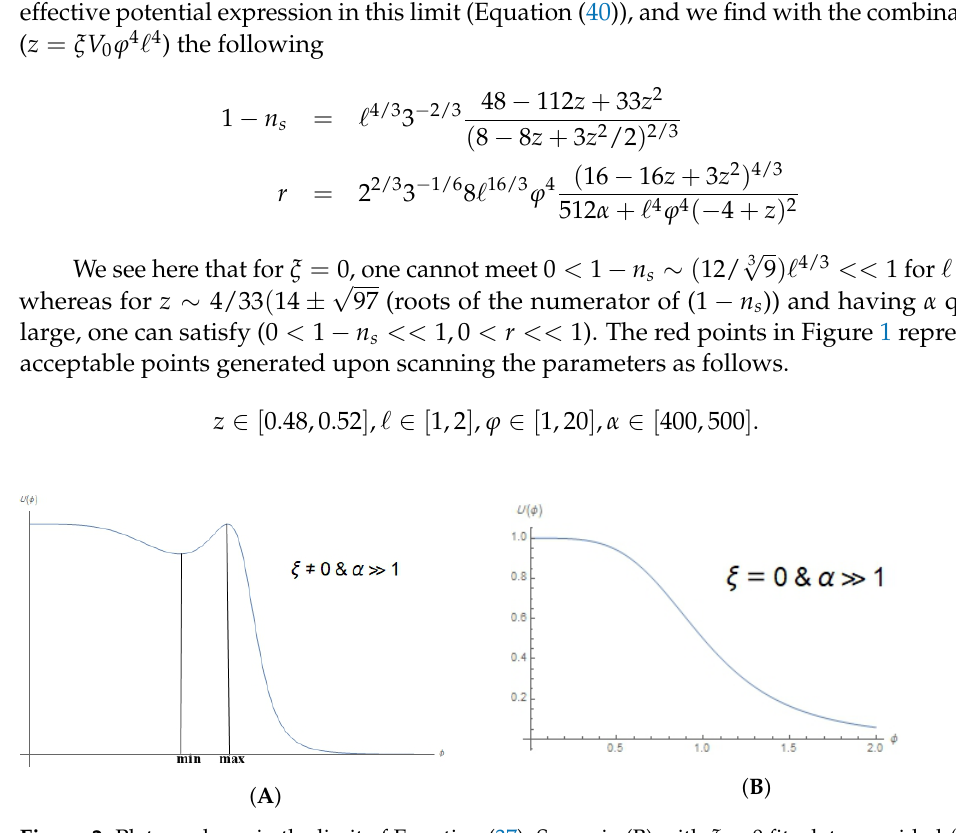
Figure 2. Plateau shape in the limit of Equation (37). Scenario (B) with ξ = 0 fits data provided (cid:96) < 1. − 1/4 ; ( B ). ξ = ) 1/4 (cid:96) − 1 . min ≡ ϕ ( A ) max ≡ ϕ 0 = ( 4 0 3 V 0 ξ